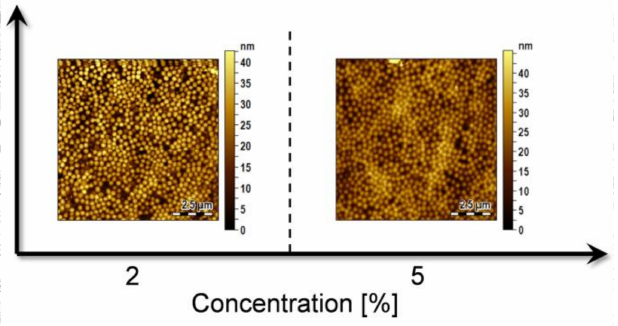
Figure 4. MGs films realized on the optical fibers tip at two different concentration, 2% and 5%, at pH 3 and at 10 ◦ C. For each concentration an area of 10 × 10 µ m above the fiber core region is